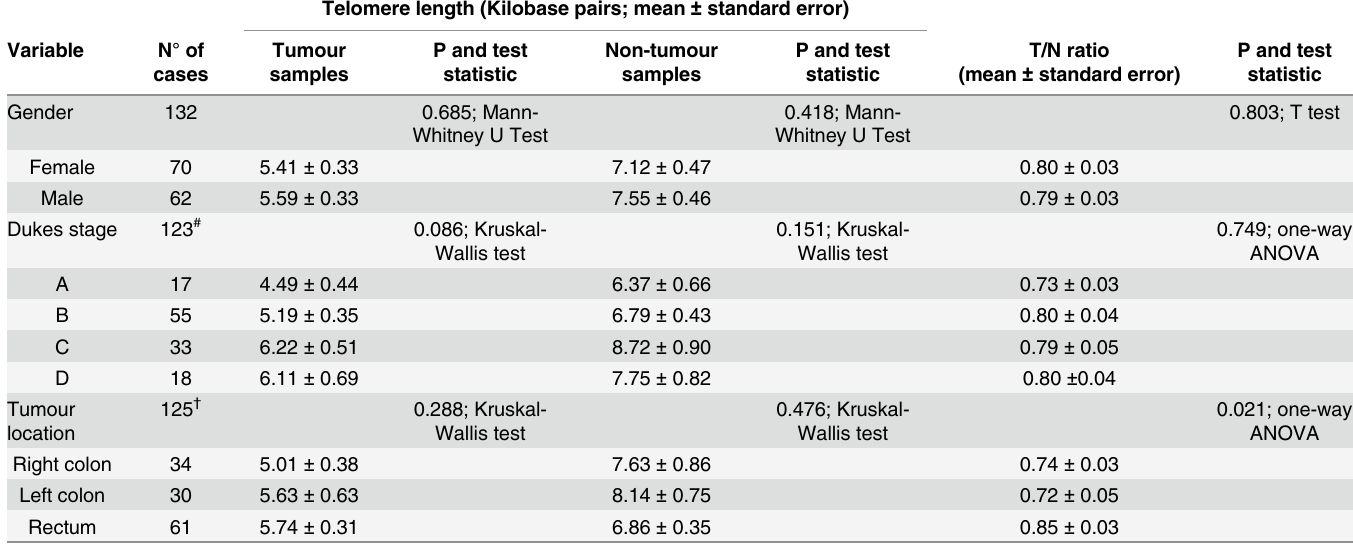
Table 1. Telomere status and clinical variables in colorectal